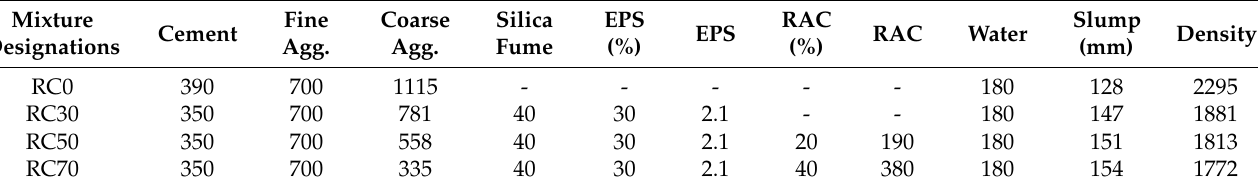
Table 2. Proportions of the concrete mixtures (kg/m 3